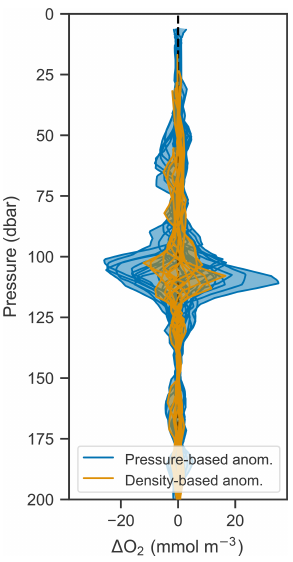
Figure 9. Anomalies of oxygen profiles from Fig. 7b shown in pres- sure (blue) and density (orange)